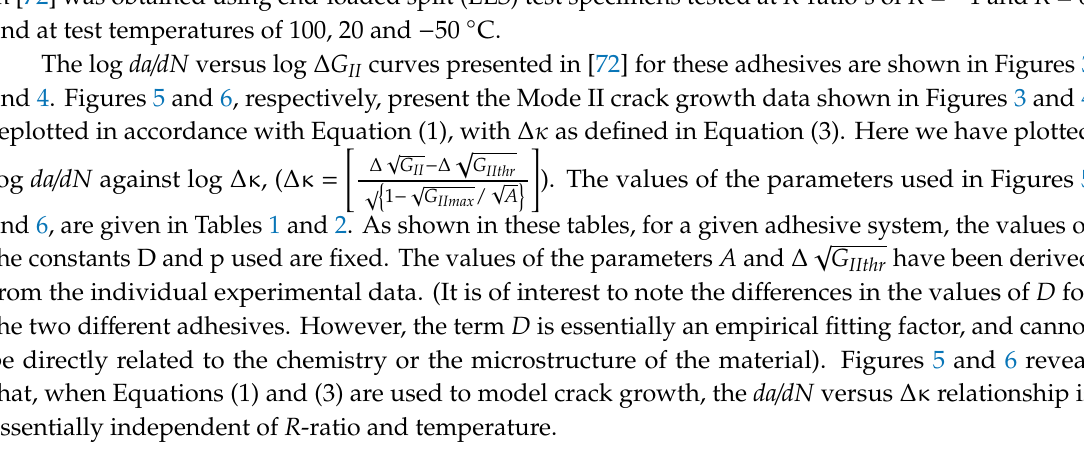
Table 1. Values of the parameters used in [60] to represent Mode II crack growth in “FM300K”. Test